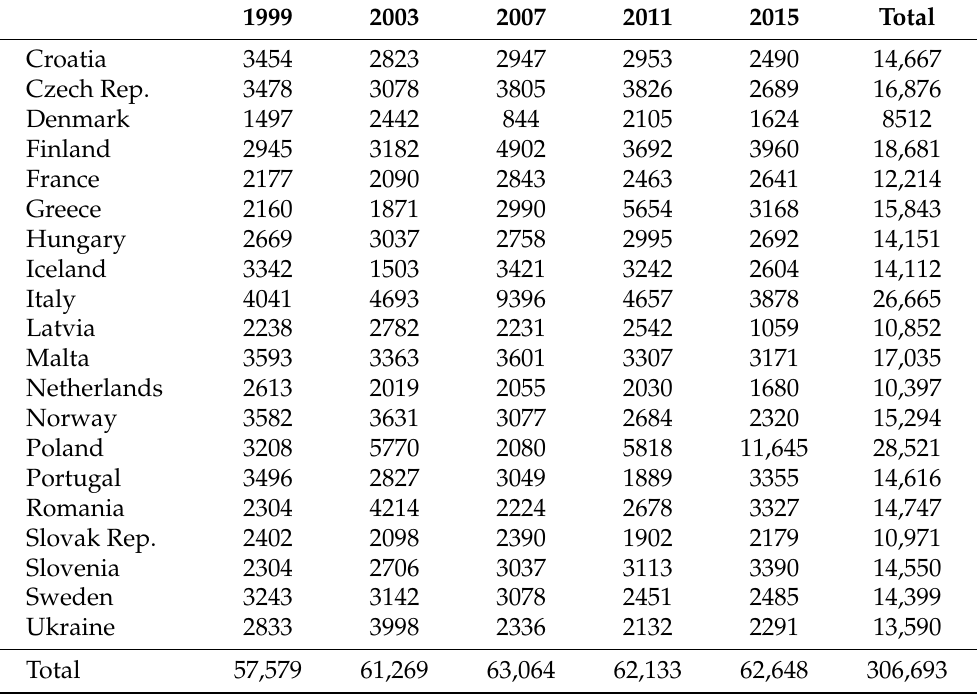
Table 1. Sample size by country and